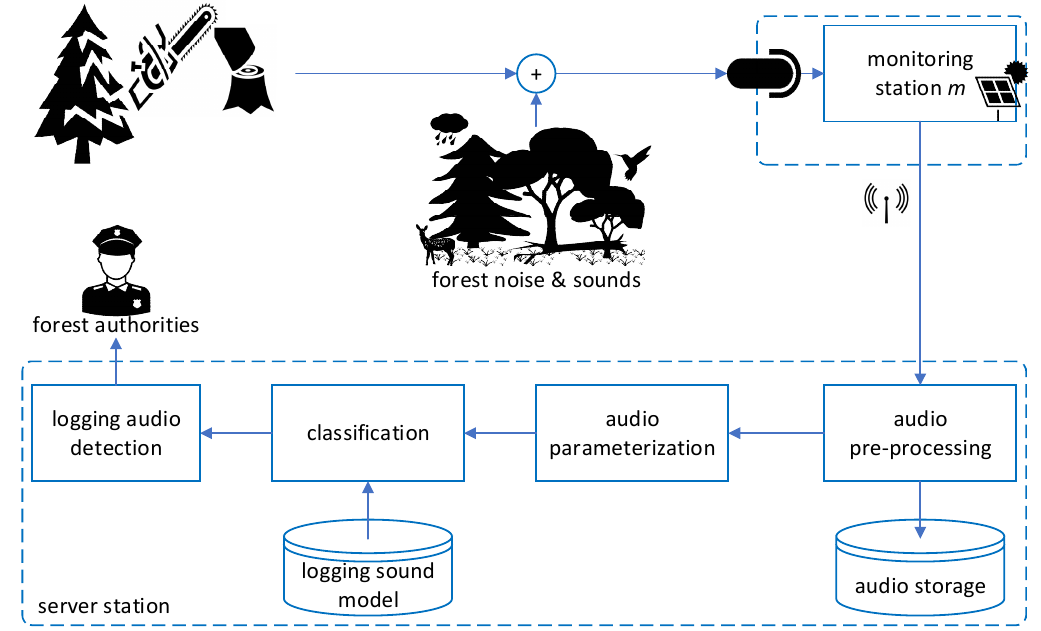
Figure 1. The overall block diagram of the concept of the logging detection system.